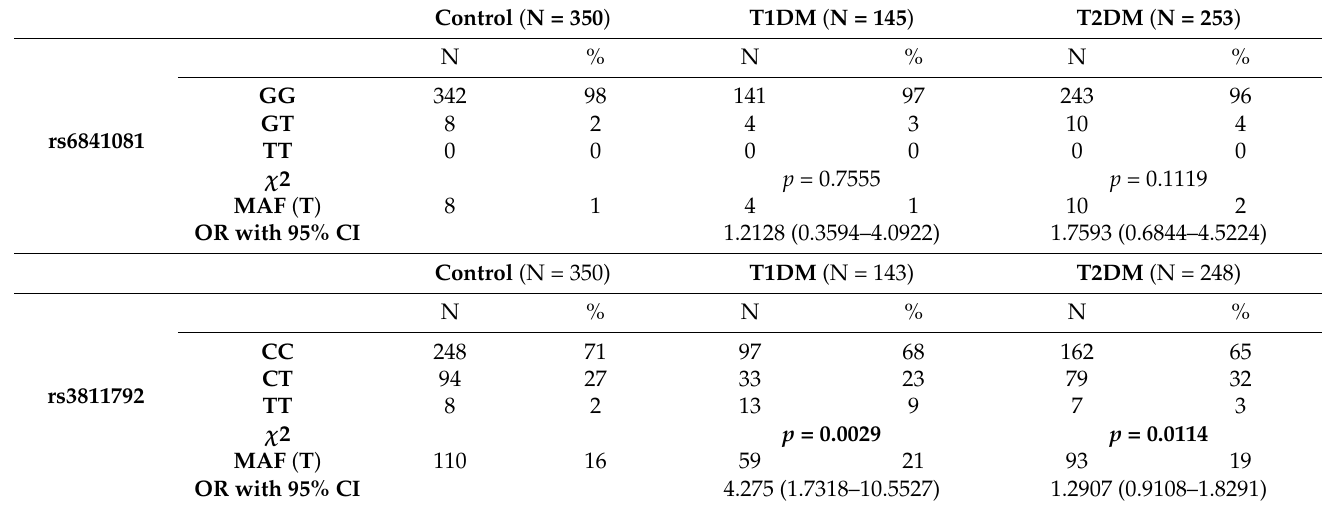
Table 4. Comparison of genotype frequencies of rs6841081 and rs3811792 polymorphisms in control, T1DM and T2DM populations. MAF: minor allele frequency; OR: odds ratio; CI confidence